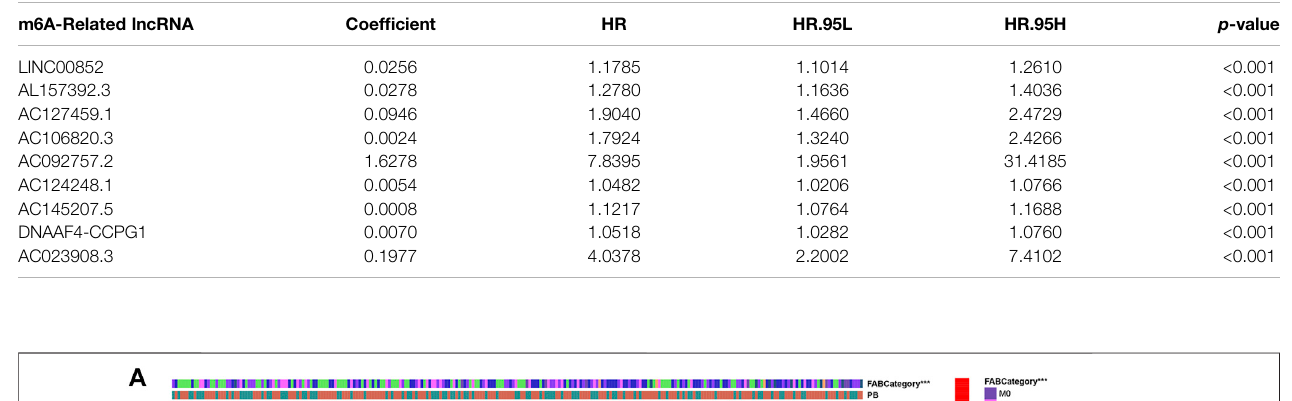
TABLE 3 | Nine lncRNAs obtained by LASSO-Cox regression.